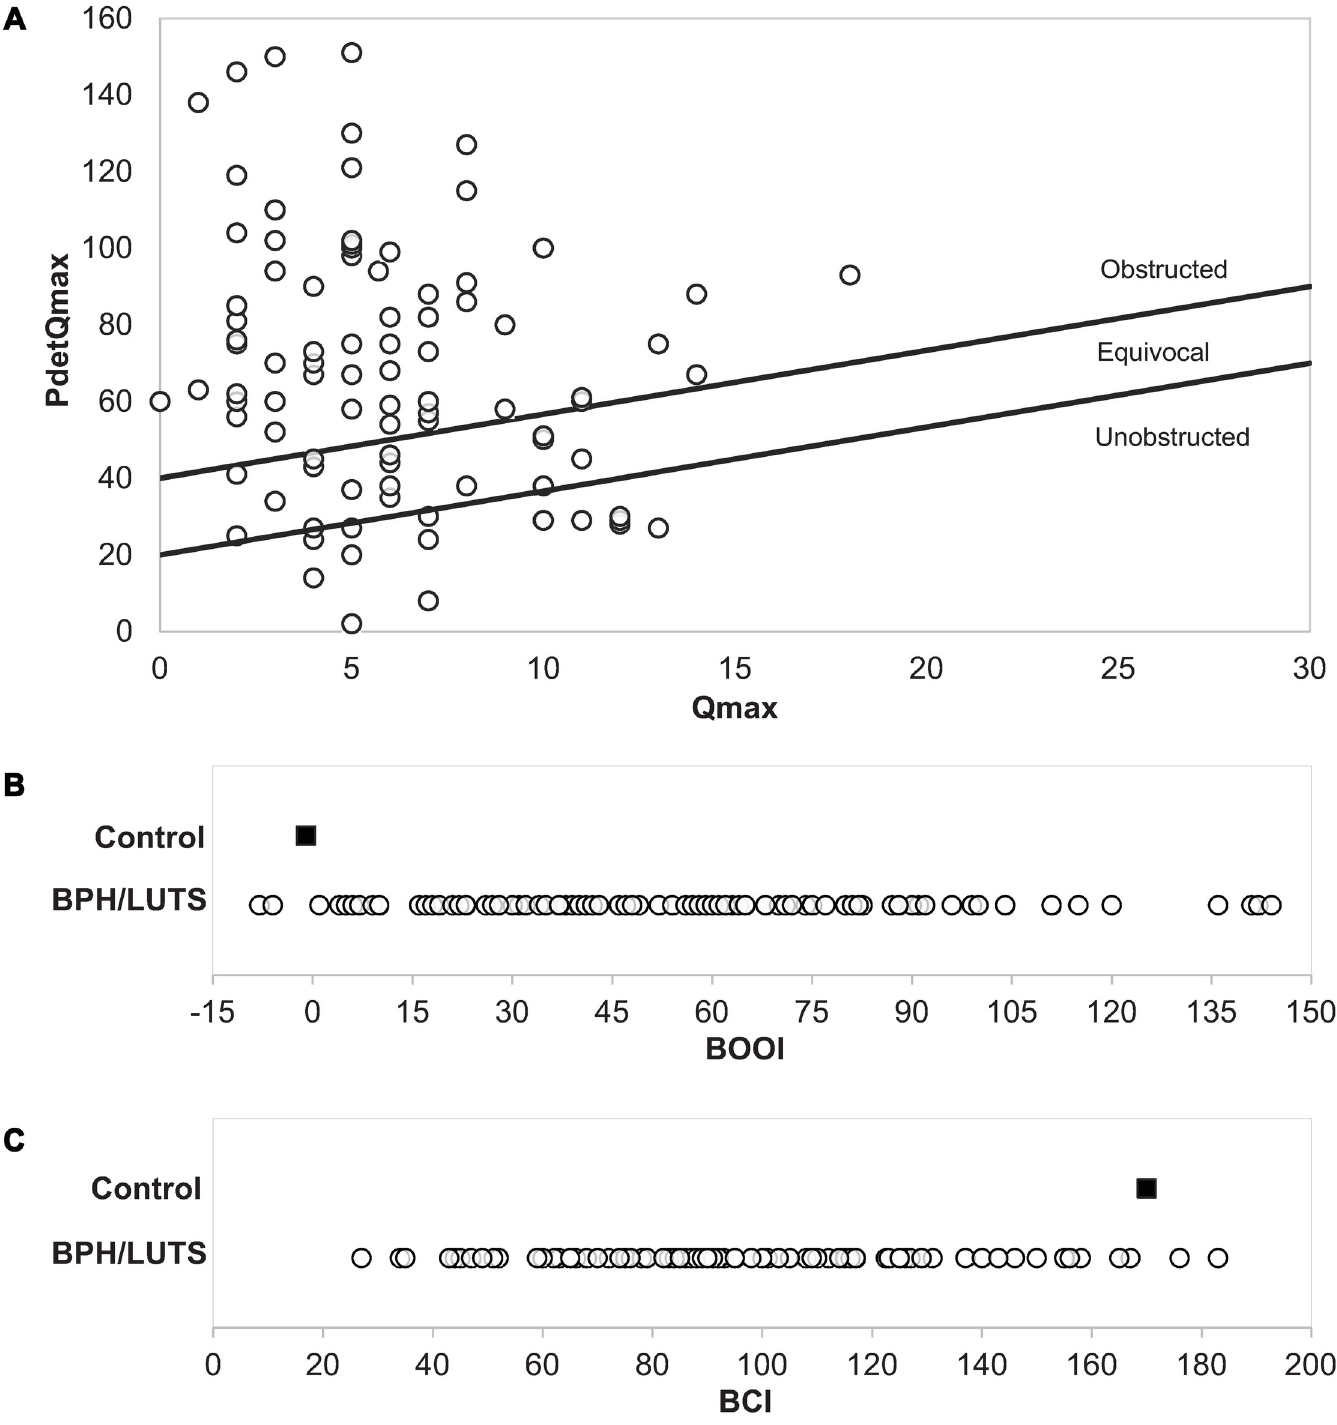
Fig 1. Preoperative urodynamic data. Open circle: BPH/LUTS patients. Filled Square are mean values calculated from published urodynamic data on young healthy controls (Schmidt et al., 2002). (A) ICS nomogram. (B) BOOI: Unobstructed < 20, Equivocal 20–40, Obstructed > 40. (C) BCI: Weak < 100, Normal 100–150, Strong >